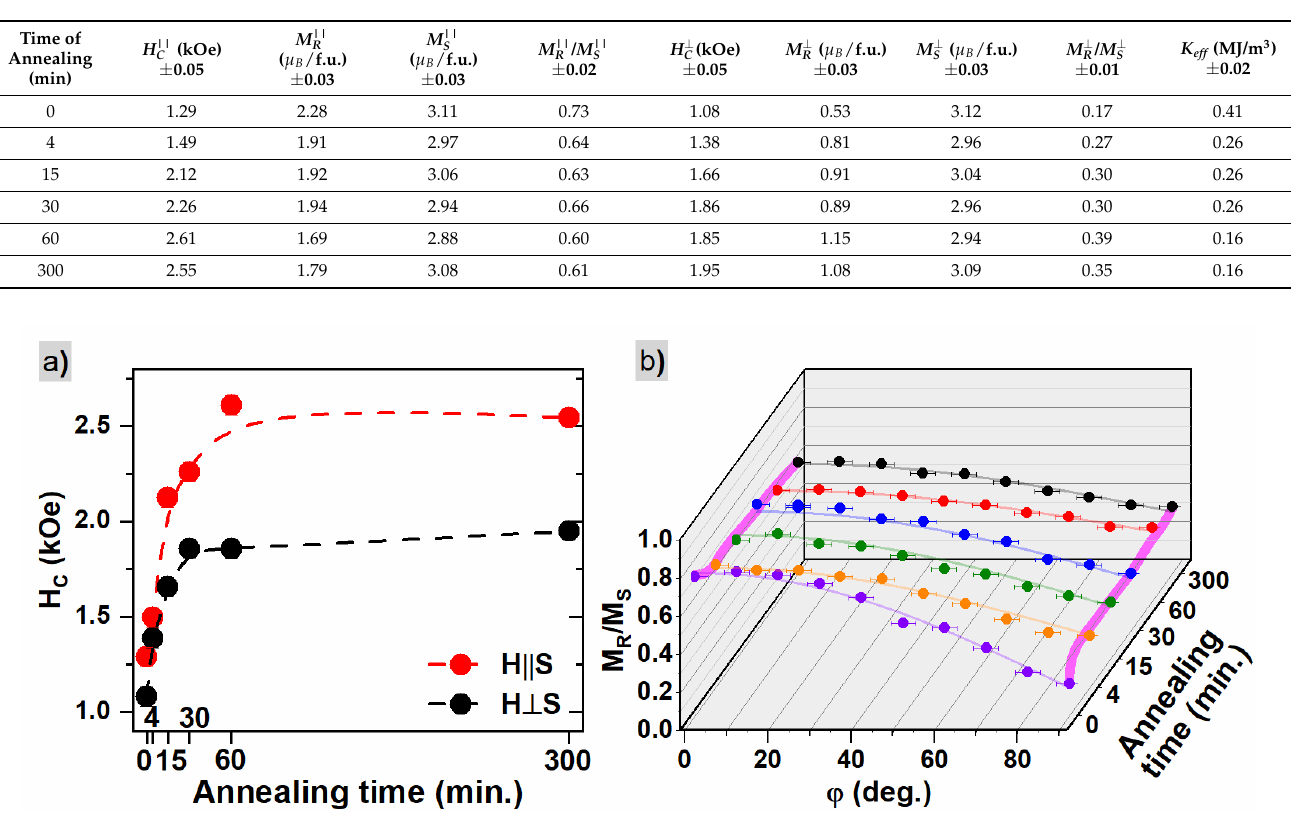
Table 1. Coercive field H C , remanence M R and saturation magnetization M S , loop squareness M R / M S for in-plane and out-of-plane measurements, and effective energy density anisotropy con- stant K ef f .